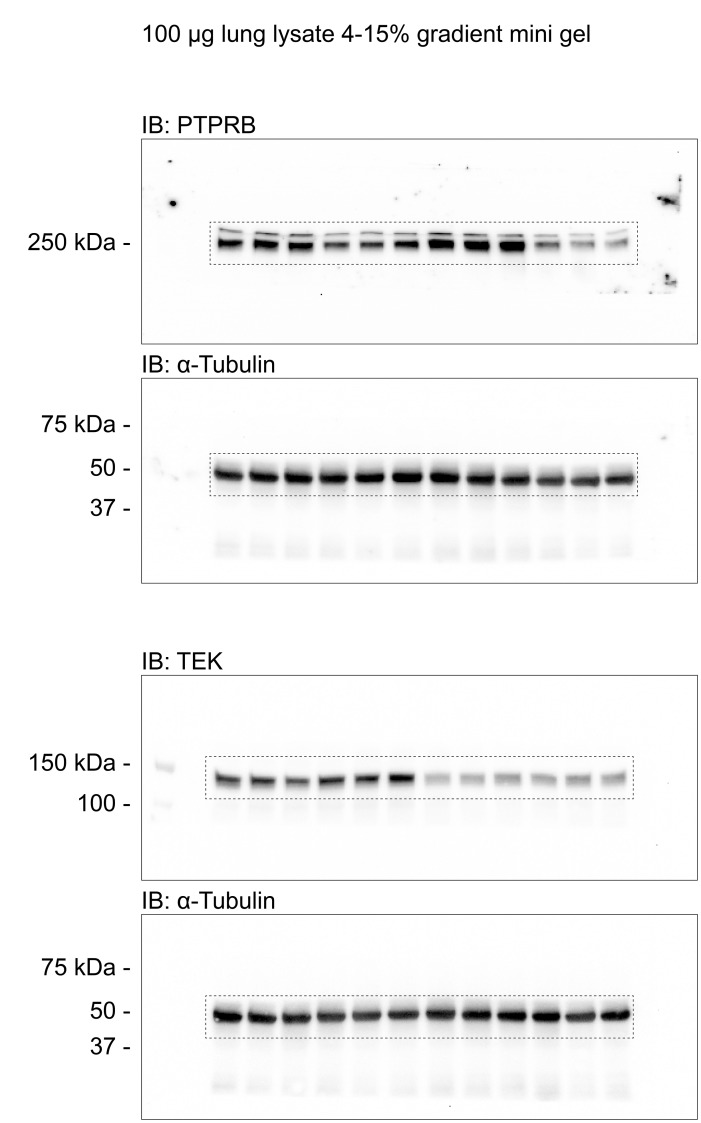
Uncropped images corresponding to the western blots presented in Figure 1A.